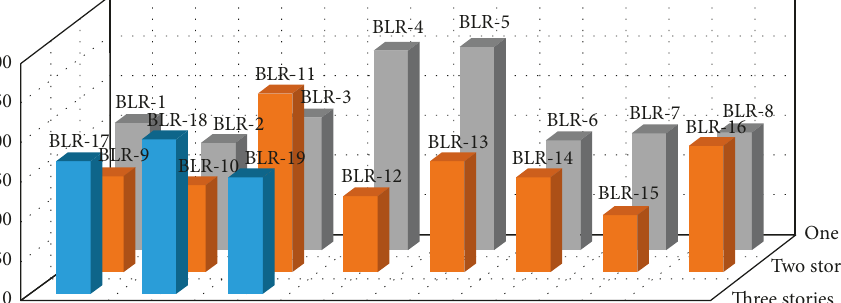
Figure 1: Number of schools in each of the 19 school building configurations.